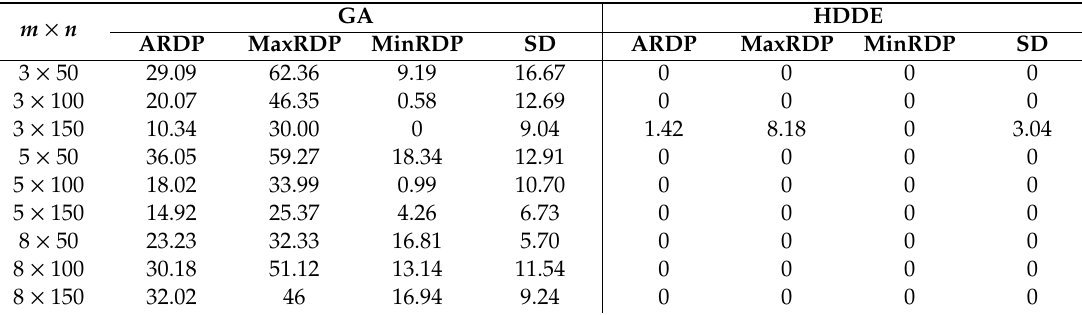
Table 10. Comparison between HDDE and GA.